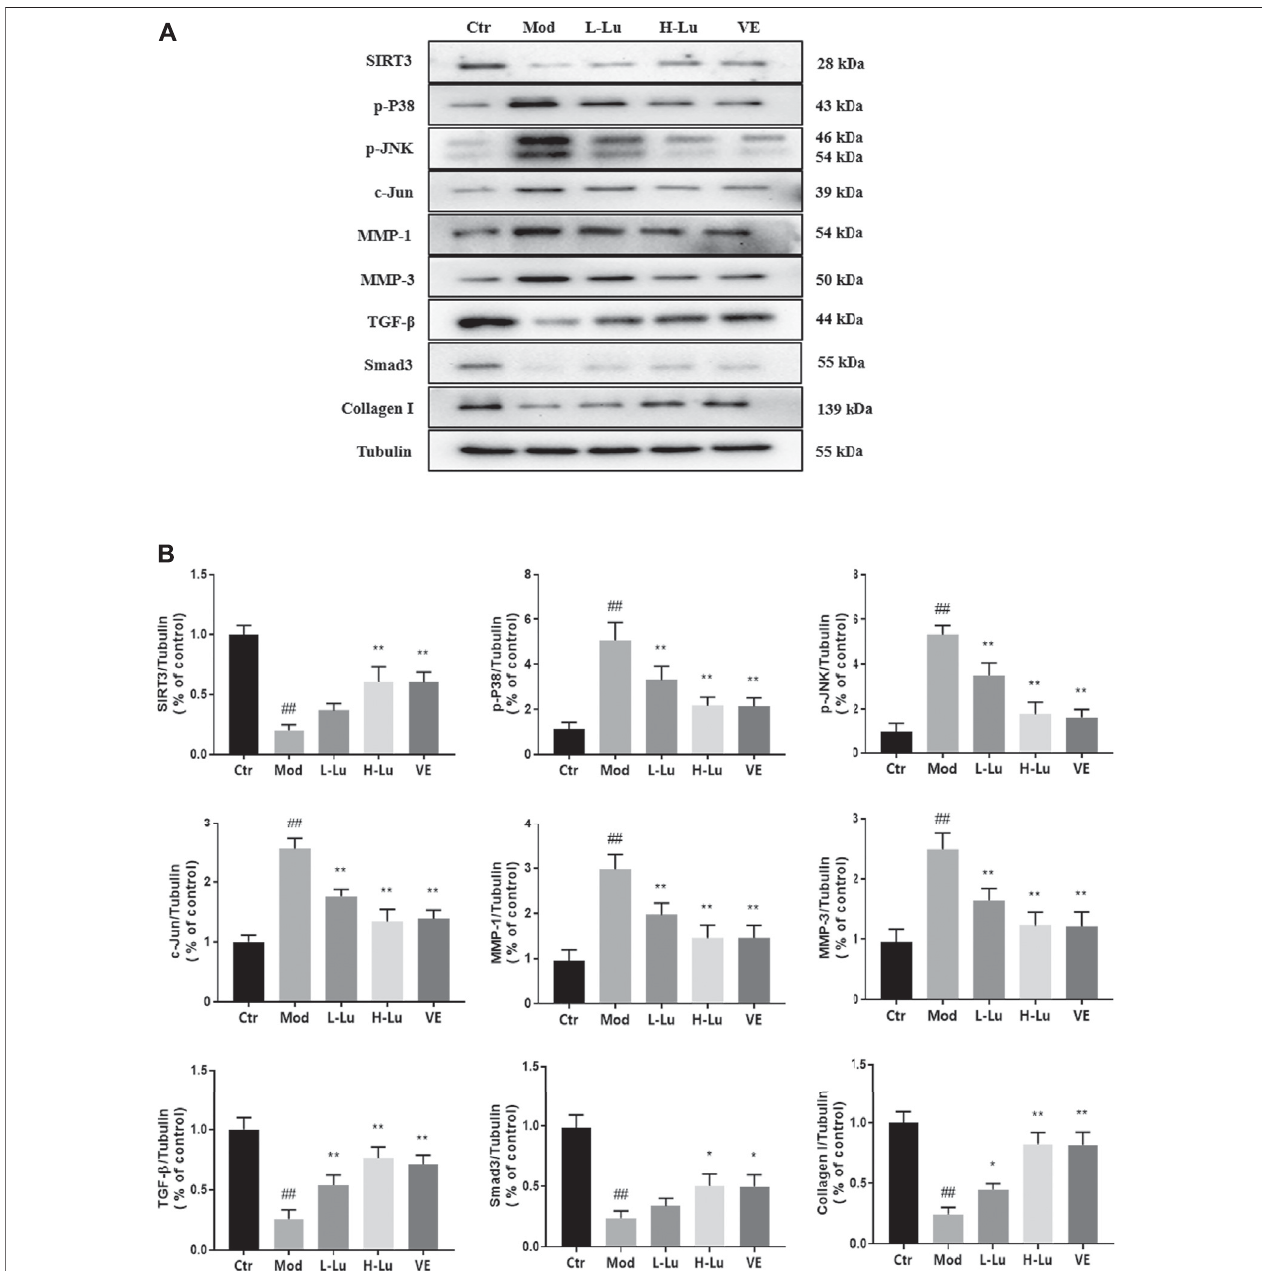
FIGURE 3 | Luteolin inhibits UVB-induced activation of MMPs and p38 MAPK in vivo . (A) Representative immunoblots of SIRT3, p-P38, p-JNK, c-Jun, MMP-1, MMP-3,TGF- β ,Smad3andCollagenIproteinexpressionsinskintissue. (B) OpticaldensityhistogramsofSIRT3/Tubulin,p-P38/Tubulin,p-JNK/Tubulin,c-Jun/Tubulin, MMP-1/Tubulin, MMP-1/Tubulin, MMP-3/Tubulin, TGF- β /Tubulin, Smad3/Tubulin and Collagen I/Tubulin. # indicates signi fi cant difference between the model group and the blank group (# p < 0.05; ## p < 0.01); * indicates signi fi cant difference between the administered group and the model group (* p < 0.05; ** p < 0.01).